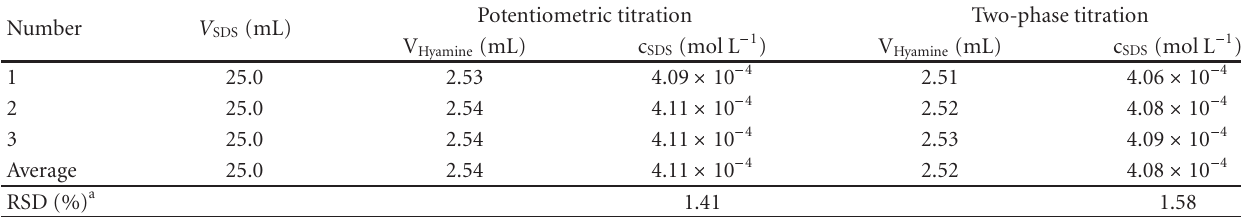
Table 4: Results of determining the concentration of SDS by potentiometric titration using anionic surfactant selective electrode compared with the two-phase titration in sample solutions. Number